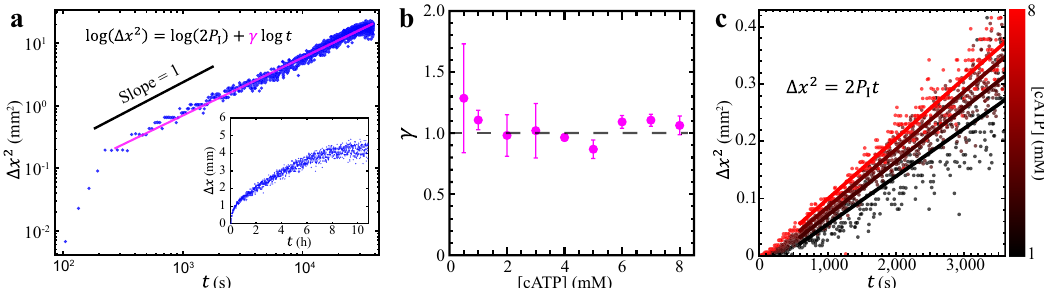
Fig.2|(Experimentalresults)Theprogressionoftheactive-inactiveinterfaceis governedbyadiffusion-likeprocessofATPattheinterface.a Squaredinterface displacement ( Δ x 2 ) as a function of time ( t ) reveals a long-term ( t ≳ 200s) linear relation: Δ x 2 (cid:4) t γ with the interface progression exponent γ ≈ 1. Inset: The interface displacement versus time shows that the interface moves rapidly initially and then graduallyslows down. b The interface progression exponent is γ ≈ 1 on averageand is independent of the caged ATP concentration. Each error bar represents the standard deviation of ≥ 3 trials. c Selected examples of squared interface